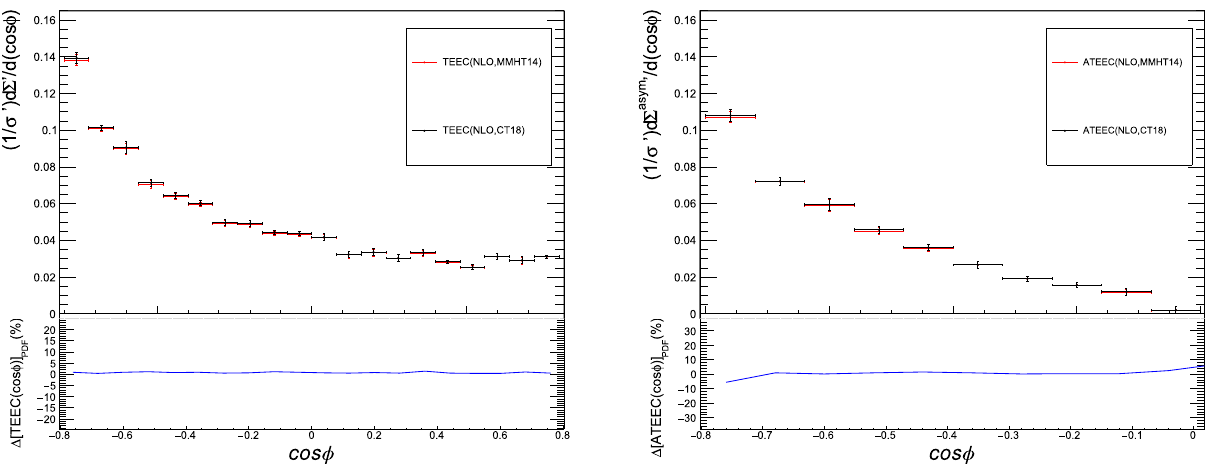
Fig. 3 Differential distribution 1 /σ (cid:7) d (cid:9) (cid:7) / d ( cos φ) and its asymmetry 1 /σ (cid:7) d (cid:9) (cid:7) asym / d ( cos φ) as in Fig. 2, but for the high- Q 2 range 150GeV 2 < Q 2 < 1000GeV 2 at